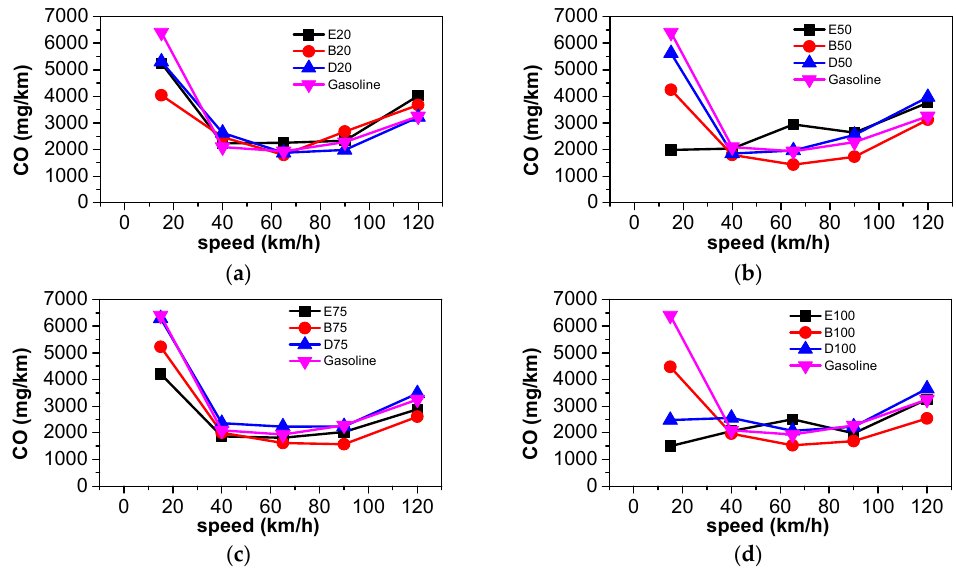
Figure 7. Comparison of CO emissions of different fuels at different blending ratios: (a) 20% blending ratio; (b) 50% blending ratio; (c) 75% blending ratio; and (d) 100% blending ratio.